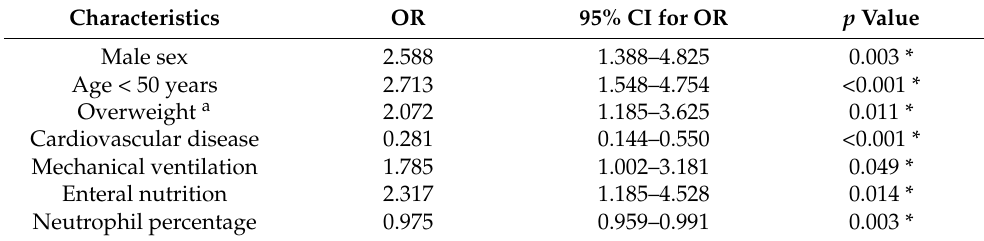
Table 2. Multivariate analysis of risk factors for